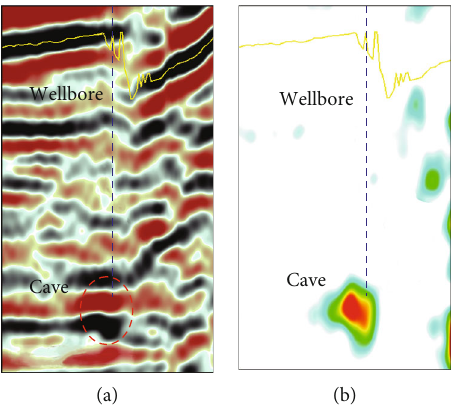
Figure 1: Geological information of the well drilling into a large-size cave. (a) Seismic section. (b) Residual wave impedance